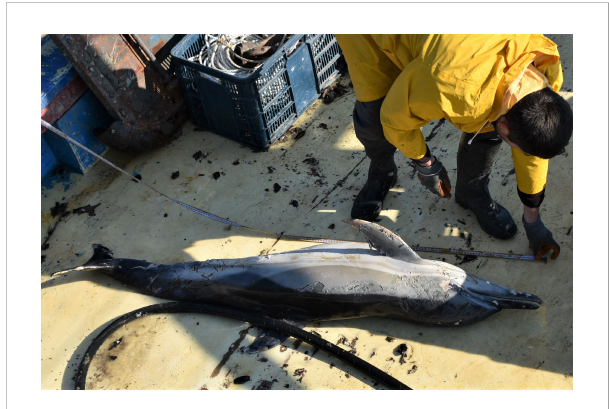
FIGURE 3 Bycaught Black Sea common